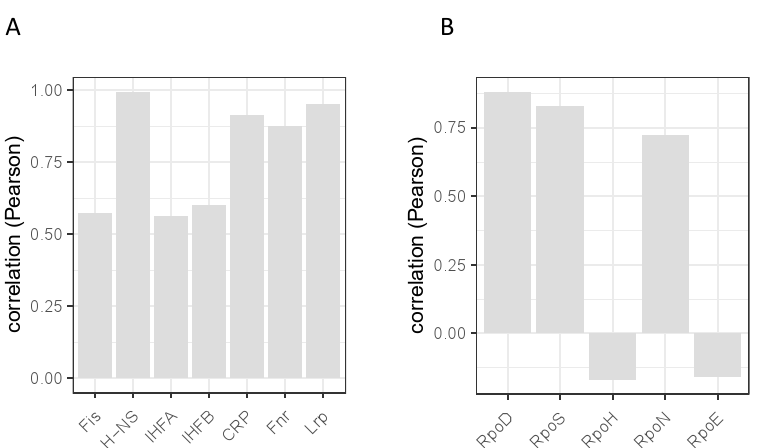
Figure 9. Correlation between the expression patterns of regulators and their cognate regulons. ( A ). Pearson correlation (ordinate) between the expression of NAP genes and their corresponding regulons. Individual regulators for which the correlations between cognate gene/regulon expression were calculated are indicated on the abscissa. ( B ). Pearson correlation between the expression of sigma factor genes and their corresponding regulons (data from